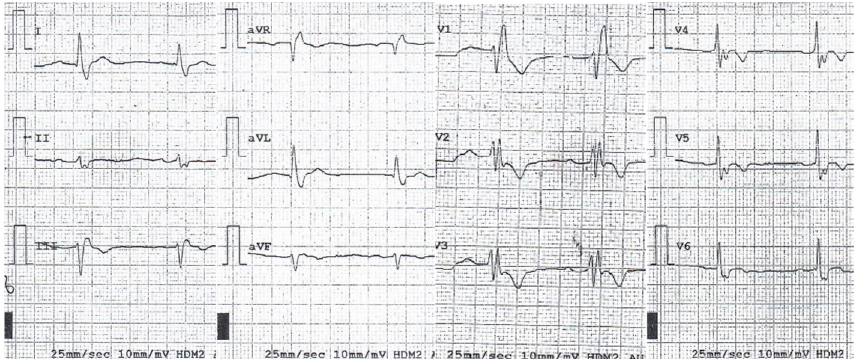
Figure 3. Proband’s ECG tracing showing an incomplete right bundle branch block (RBBBi) associated with 1st degree atrio-ventricular block (AVB).